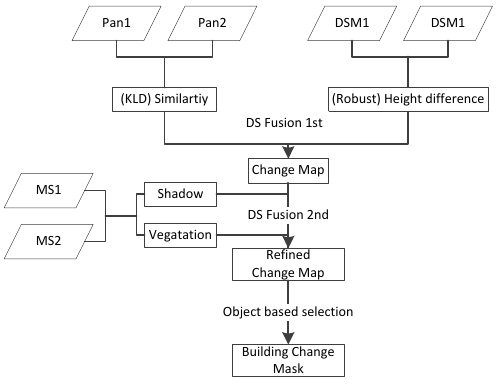
Figure 2. Flow chart of Method II (Tian et al.,